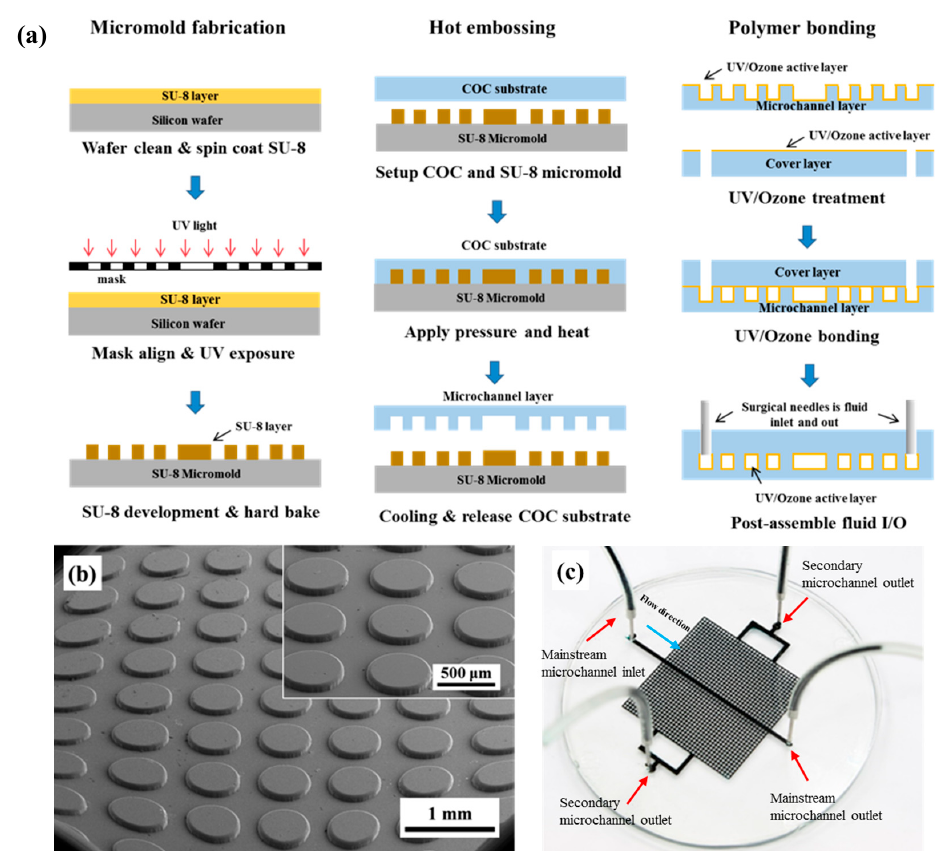
Figure 2. ( a ) Schematic of the micromodel fabrication flow chart. ( b ) 40× fisheye SEM image of the SU-8 micromold showing microcavity arrays. The top-right corner shows an enlarged 100× SEM image. ( c ) Micromodel with black-food-dye injection.